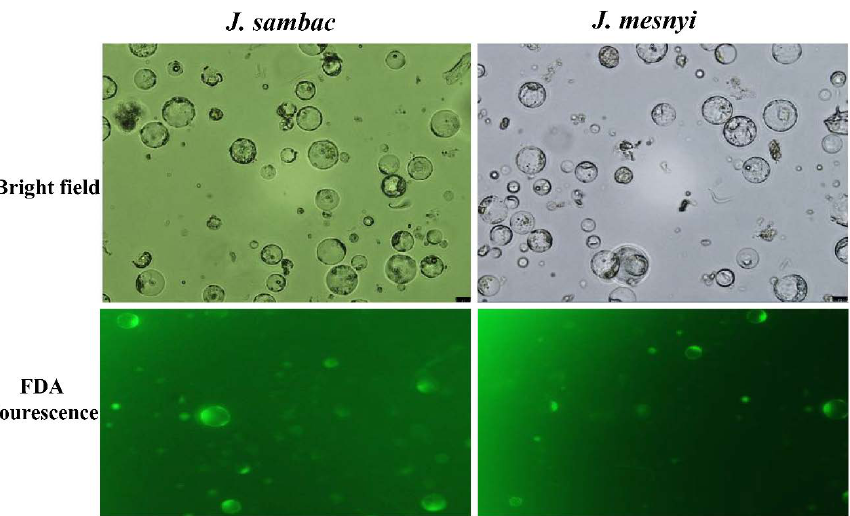
Figure 2. Protoplast isolation from callus tissue of J. sambac L. and J. mesnyi . Freshly isolated protoplasts from callus tissues in bright field and fluorescence channel under a confocal microscope. Bar = 25 µm.